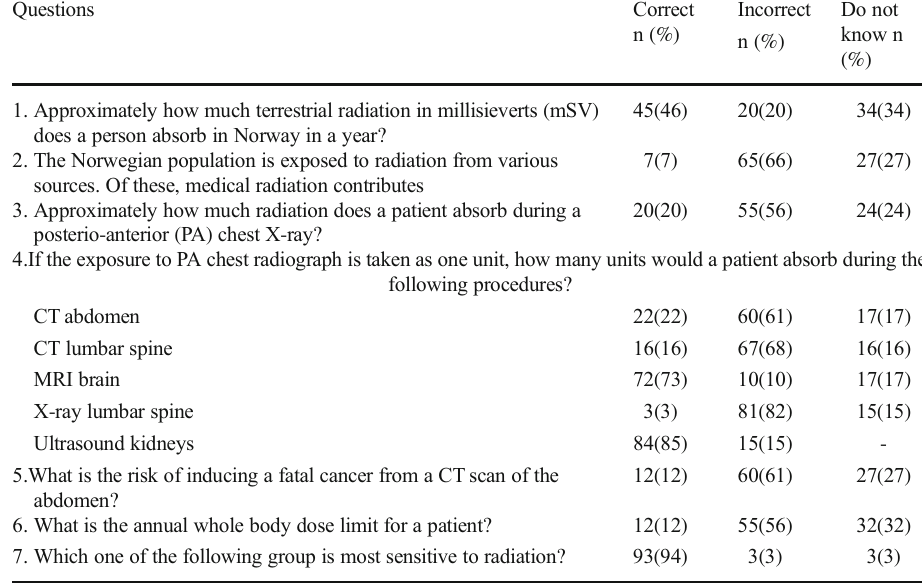
Table 3 Frequency distributions of responses to questionnaires